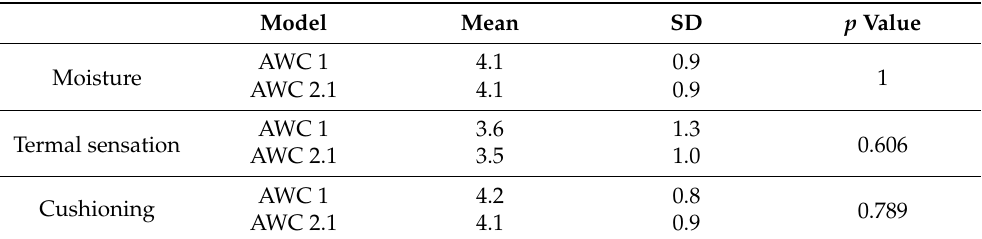
Table 5. Perceived comfort in terms of physiological characteristics between the AWC 1 and AWC 2.1 sock models.